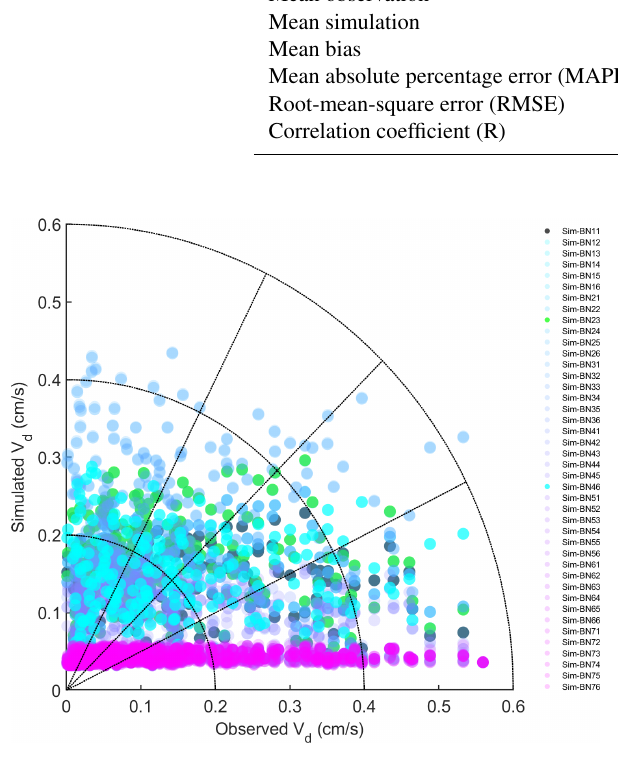
Figure 2. Comparison of observed and simulated V d of NO 2 .